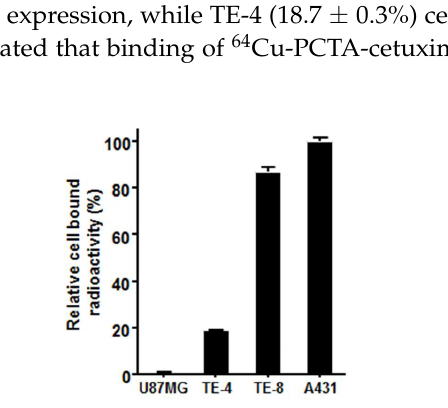
( b ) Figure 4. Antitumor effect of cetuximab in ESCC tumor models. Comparison of ( a ) TE-4 and ( b ) TE-8 tumor growth in ESCC xenograft model treated with isotype or cetuximab. Tumor growth in TE-4 was not inhibited by isotype or cetuximab treatment. TE-8 tumor markedly regressed with cetuximab treatment, but TE-8 tumor volume continuously increased with isotype treatment. * Isotype vs. cetuximab, p < 0.01. 3.4. Characteristics of 64 Cu-PCTA-Cetuximab The average number of chelates per cetuximab was determined to be 4.0 ± 0.4 by MALDI mass spectrometry. 64 Cu-PCTA-cetxuximab were prepared successfully at high radiolabeling yield (>98%) and radiochemical purity (>98%), which were checked by ITLC-SG and size-exclusion HPLC analysis. 64 Cu-PCTA-cetxuximab had favorable immunoreactive fraction of 0.972, and its radio immunoconjugate showed good in vitro serum stability (above 90%) [35,37]. 3.5. Immuno-PET Imaging of Cetuximab-Induced Antitumor Activity